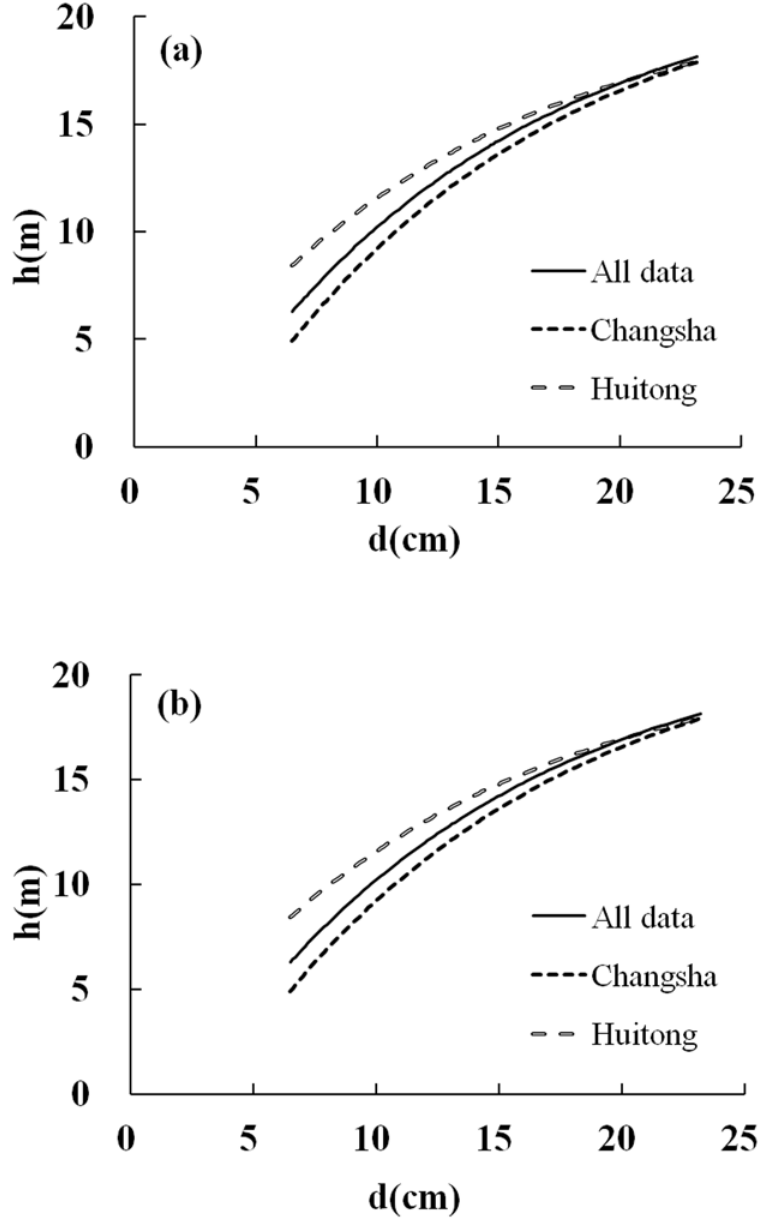
Fig 8. The height-dbh relationship for the two best models, using the following data: Dq = 15.04cm, Hm = 15.64m, D0 = 22.52cm, H0 = 22.51m, t = 18 years old, N = 2302 trees per hectare (a: Model 6; b: Model